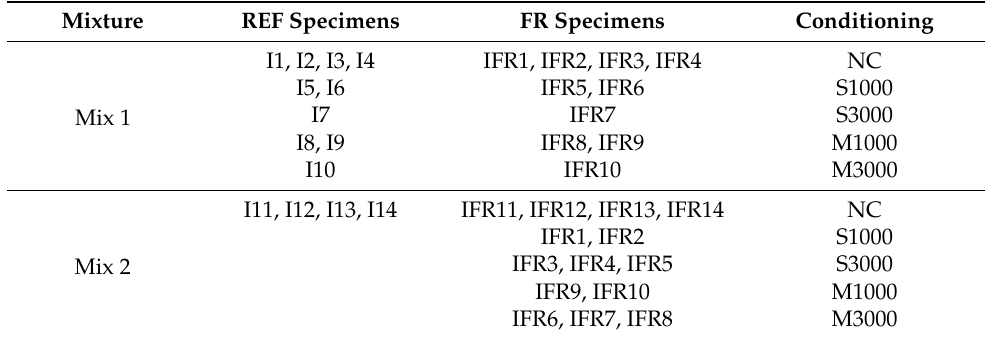
Table 2. Summary of mechanical tests according to the type of mixture, the presence of hemp fibers, and the type of environmental